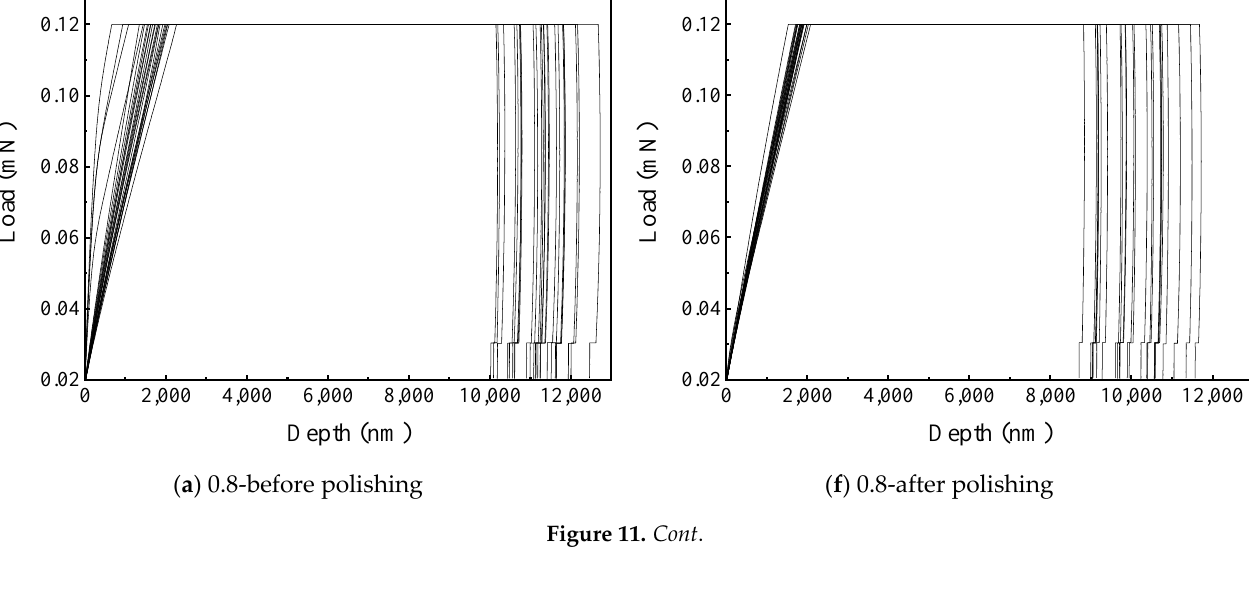
Figure 10. Nanoindentation creep curve before and after polishing of asphalt mastic specimens with RFA of 0.8. Table 4. Nanoindentation modulus of asphalt mastic specimens before and after polishing.